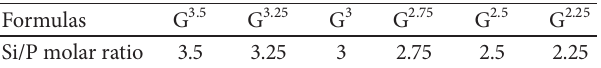
Table 2: The formulas of geopolymers